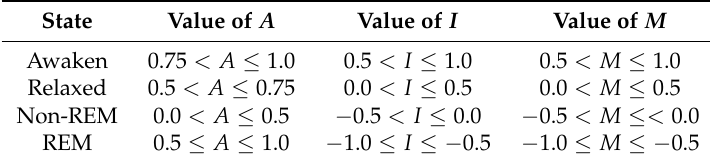
Table 1. Relations among AIM values and consciousness